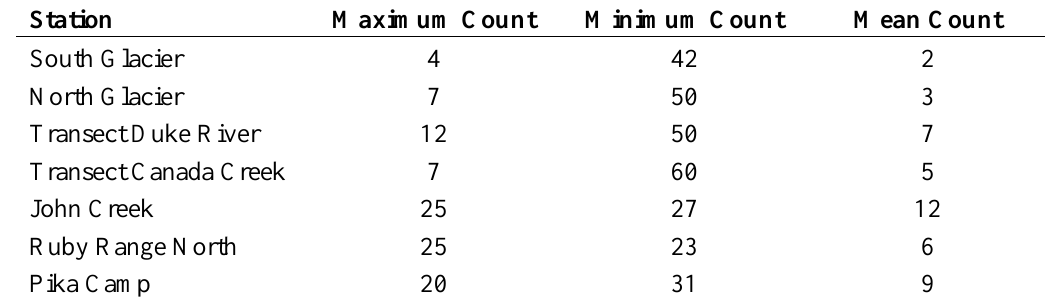
Table 3. Number of daily minimum and maximum values observed and calculated (mean) for seven meteorology stations for period between 1 May and 31 August 2008.